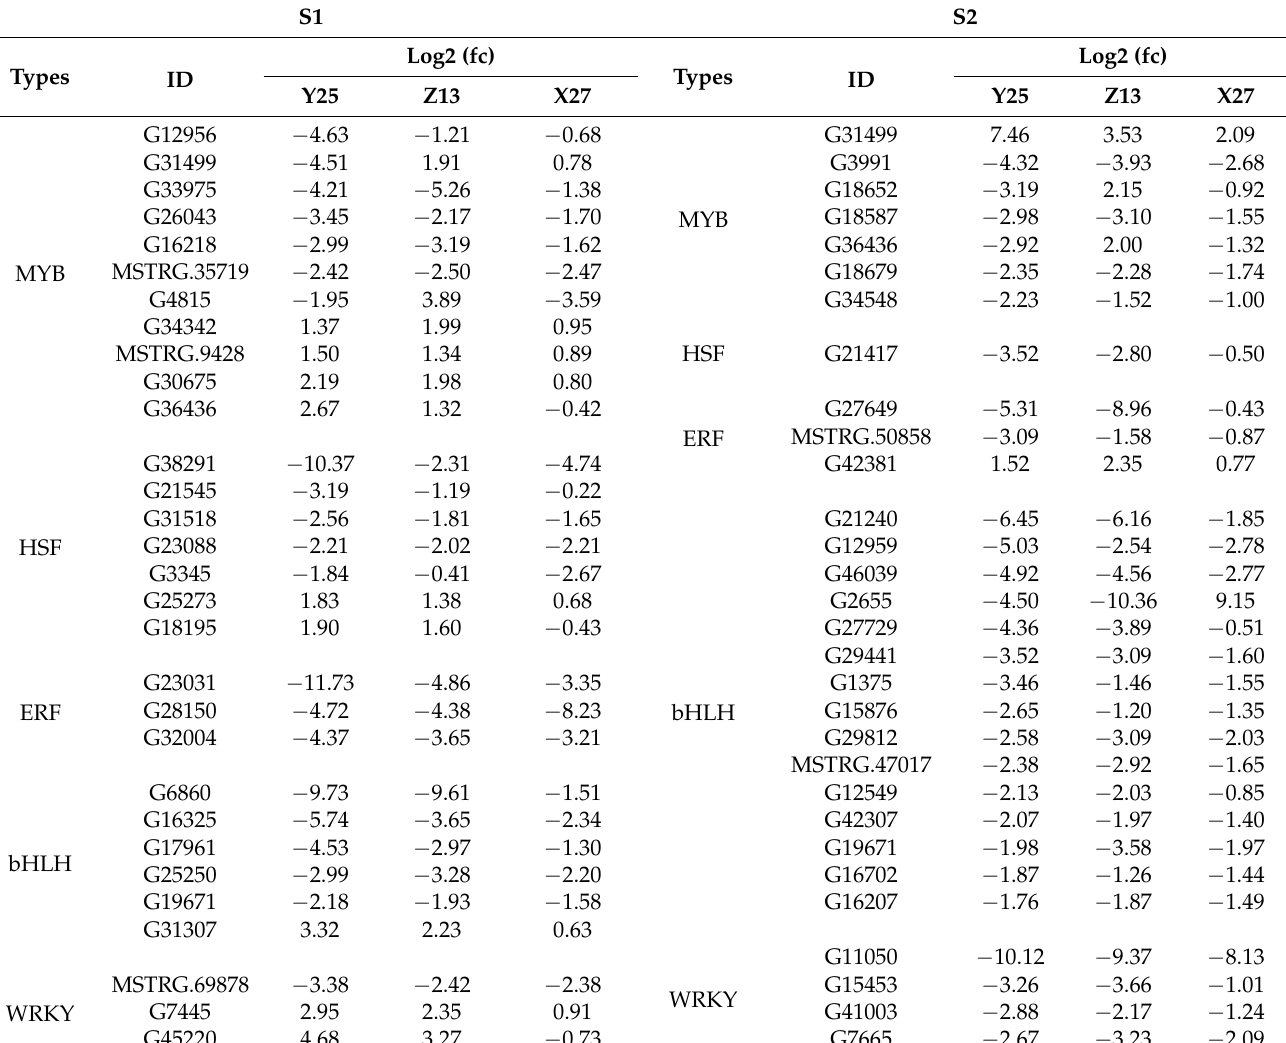
Table 2. Differentially expressed transcription factors Log2 (fc) represented the multiple of absolute difference between the sample treated at 60 ◦ C and CK. S1